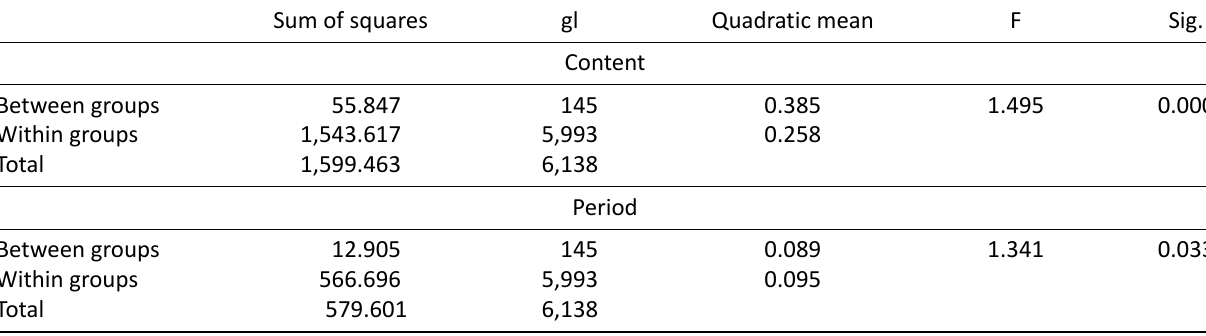
Table 2. Statistics of the analysis of the averages of the variances for RQ1. Sum of squares gl Quadratic mean F Sig.